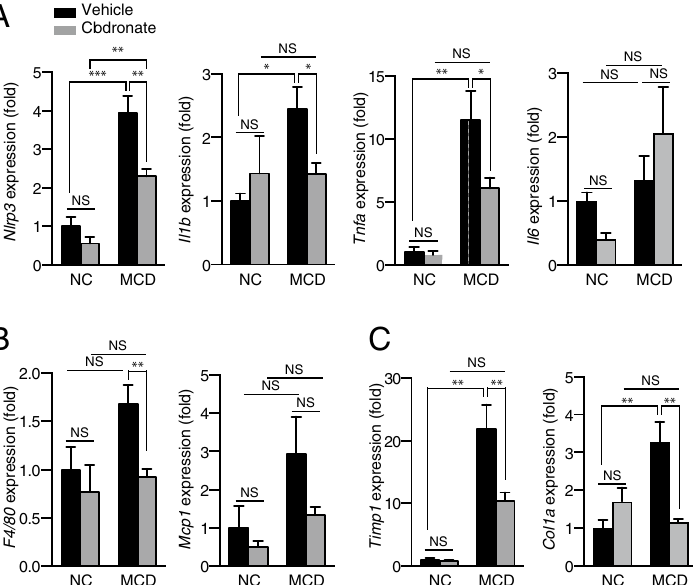
Figure 2. Clodronate suppresses inflammatory gene expression in the livers of mice fed the methionine- and choline-deficient diet. The livers of mice treated as described in Fig. 1 were analyzed by qRT-PCR [n = 10, methionine- and choline-deficient (MCD) diet-fed, per treatment; n = 3–5, normal chow (NC)-fed, per treatment]. ( A ) Relative mRNA levels of the inflammatory genes Nlrp3 , Il1β , Tnfa , and Il6 . ( B ) Relative mRNA levels of the macrophage marker F4/80 and chemokine Mcp1 . ( C ) Relative mRNA levels of the fibrosis-related genes Timp1 and Col1a1 . The data are shown as the fold change relative to the vehicle-treated group fed with the NC diet. All data are shown as the mean ± S.E.M. * P < 0.05, ** P < 0.01, *** P < 0.001. NS not